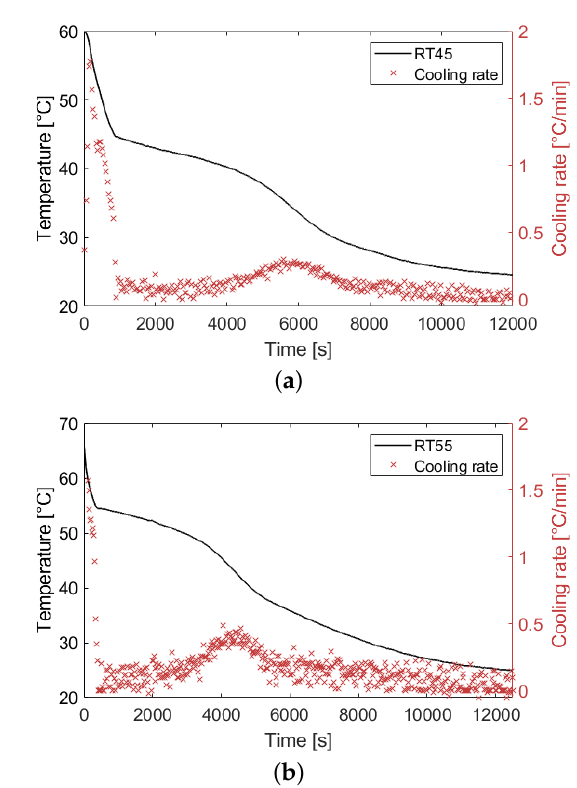
Figure 16. Heating rate from T-history test ( a ) RT45; ( b ) RT55.